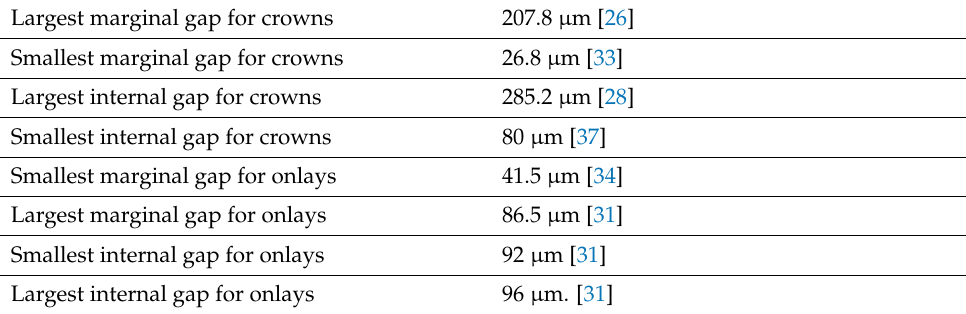
Table 5. Reported marginal and internal gaps in the included